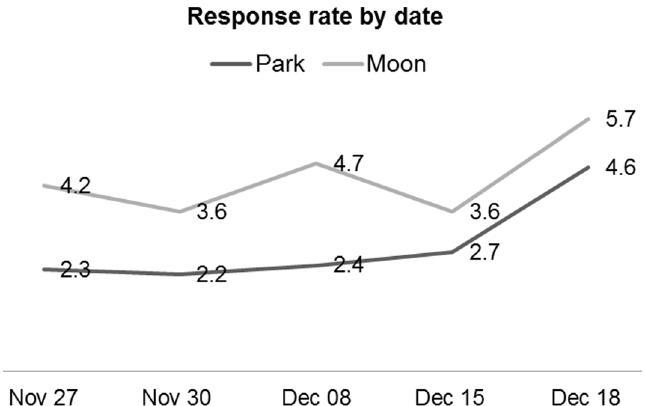
Figure 4. Response rate by date in campaign speeches.